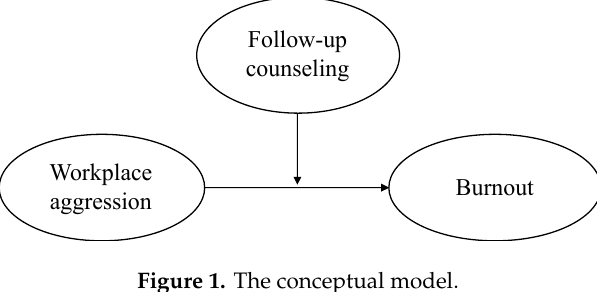
Figure 1. The conceptual model.